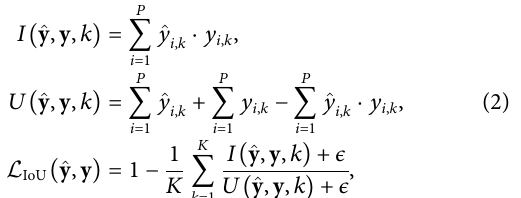
Frontiers in Robotics and AI |